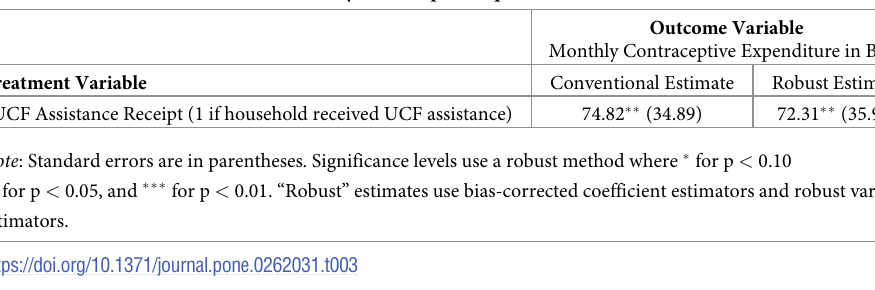
Table 3. Effect of UCF assistance on monthly contraceptive